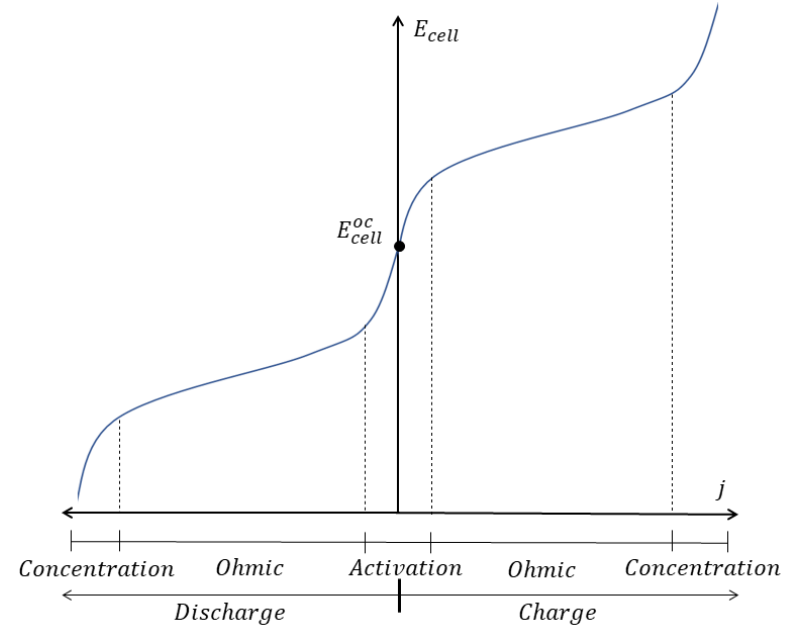
Figure 3. Illustration of the regions of prevalence of each overpotential in a cell voltage vs. current density